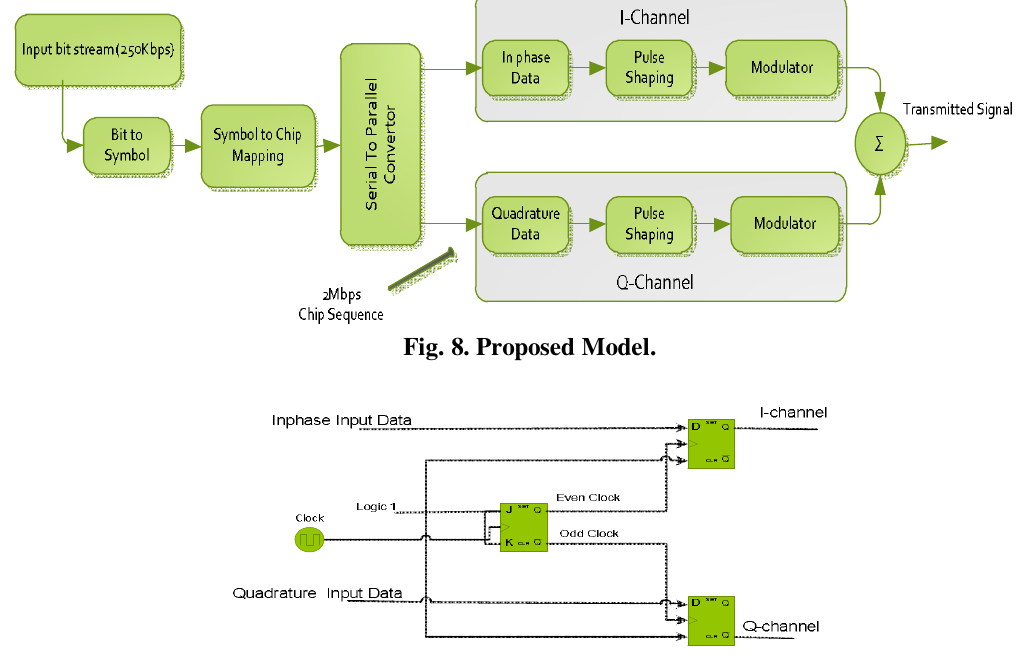
Fig. 8. Proposed Model.